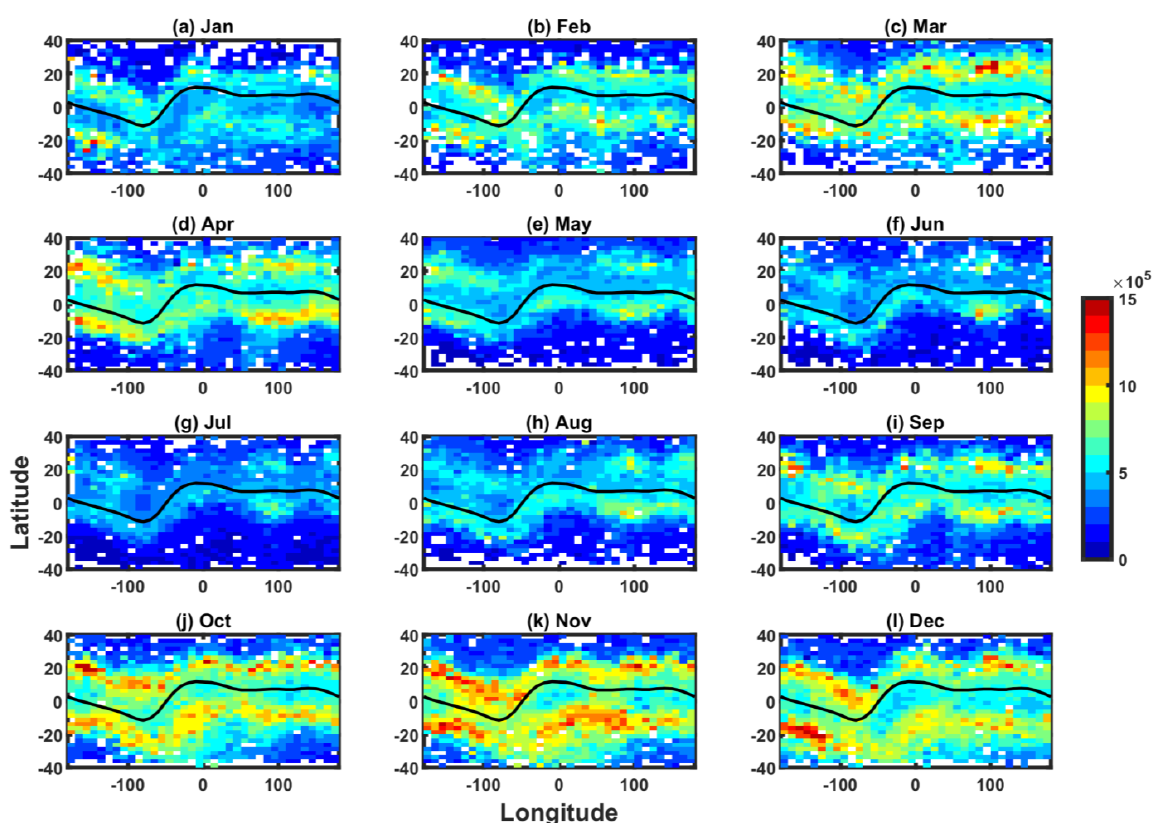
Figure 1. Latitude – longitude maps of electron density at 302.5 km (300 – 305 km mean) during 12 – 13 LT based on COSMIC-2 data. ( a – l ) January to December months in 2020. The black curve represents the magnetic equator.